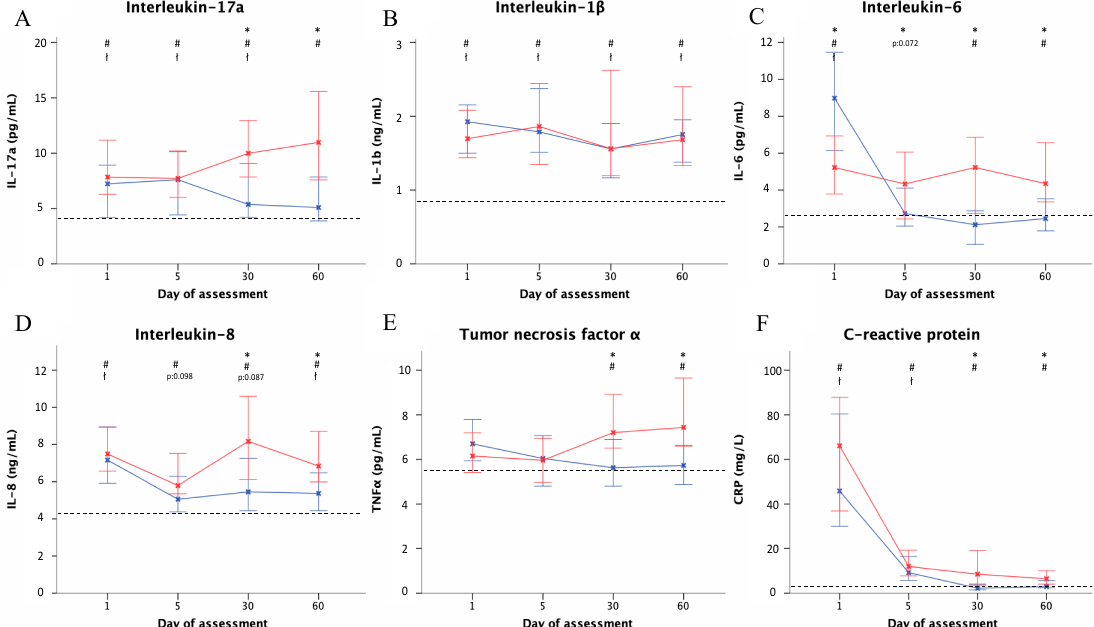
Figure 1. Inflammatory cytokine and hsCRP levels by exacerbation severity and day of assessment. Data are shown for severe exacerbations (inpatients; red) and non-severe exacerbations (outpatients; blue) and by day of assessment (days 1, 5, 30, and 60): ( A ) Interleukin (IL)-17a; ( B ) IL-1 β ; ( C ) IL-6; ( D ) IL-8; ( E ) TNF- α ; ( F ) hsCRP. The dashed line shows the median in control (stable) patients. Blades represent the median and error bars represent 95% Confidence Intervals. * p < 0.05 (severe vs. non-severe exacerbations), # p < 0.05 (severe exacerbations vs. controls), ł p < 0.05 (non-severe exacerbations vs. controls). Abbreviations: hsCRP, high-sensitivity C-reactive protein; TNF- α , Tumor necrosis factor alpha.